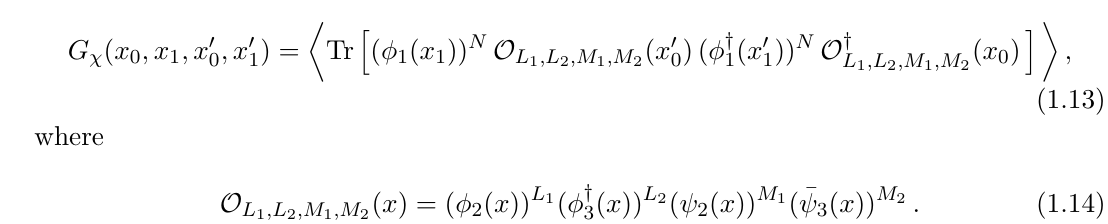
Figure 3 . Graphic representation of the Feynmann integral I χ ( x 0 , x 1 , x 0 lattice bulk N × ( L lattice of size N × ( M appearing on the right part of the graph and corresponding to the M and the M